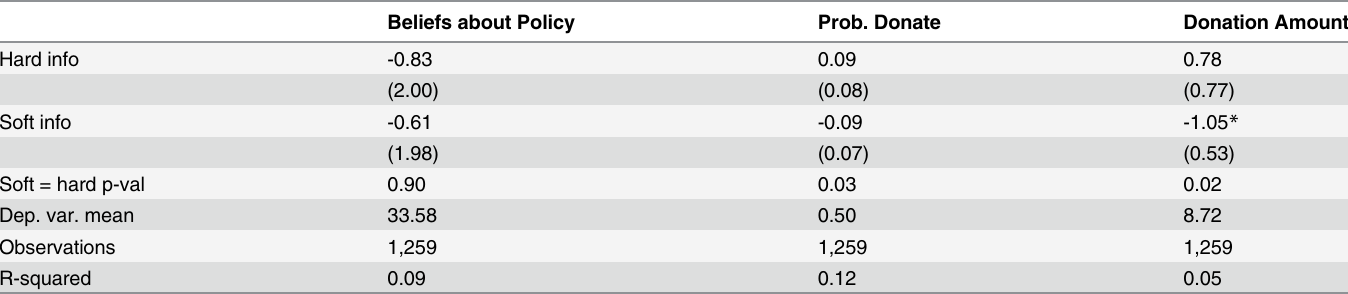
Table 2. Average short-run effects of information on policy actions. Beliefs about Policy Prob.